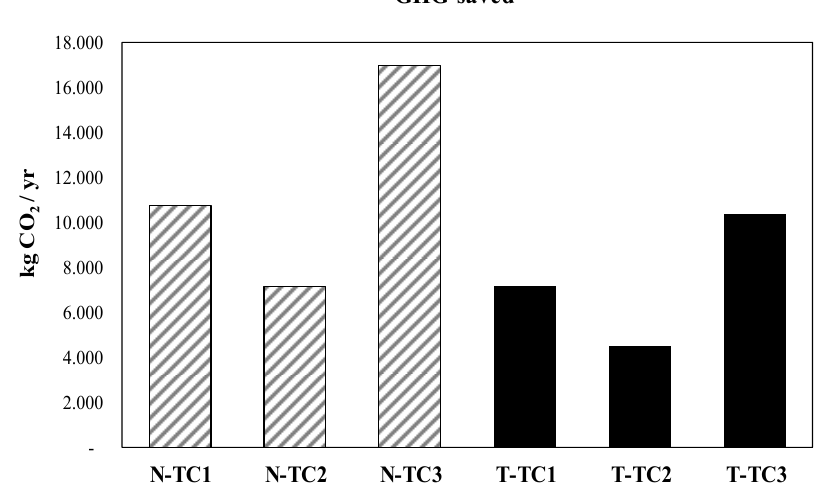
Figure 5. Amount of CO 2 saved (kg) yearly in all scenarios analyzed.